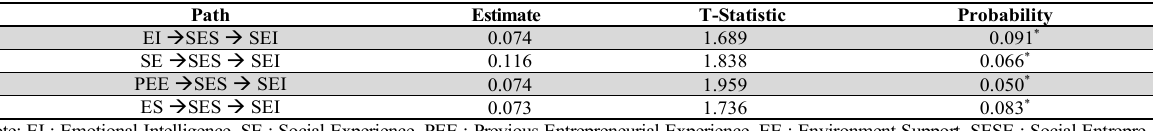
Mediation Test Result on Sobel